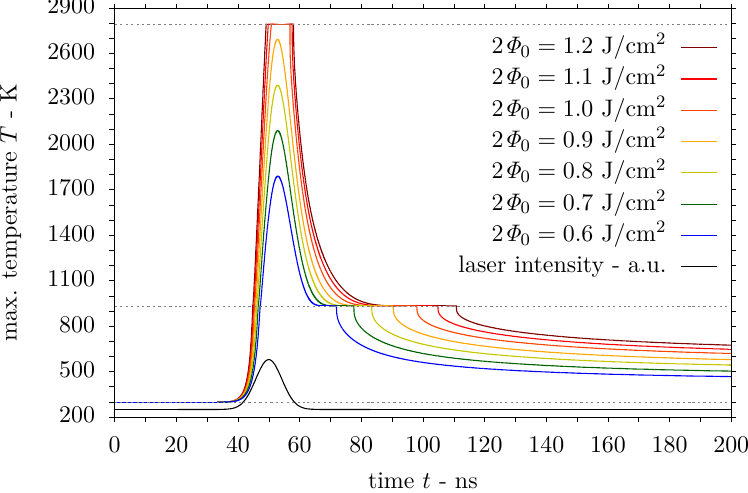
Figure 8. Surface temperature at interference maximum during single pulse DLIP of high-purity aluminium substrate as a function of time according to SPH predictions for different laser